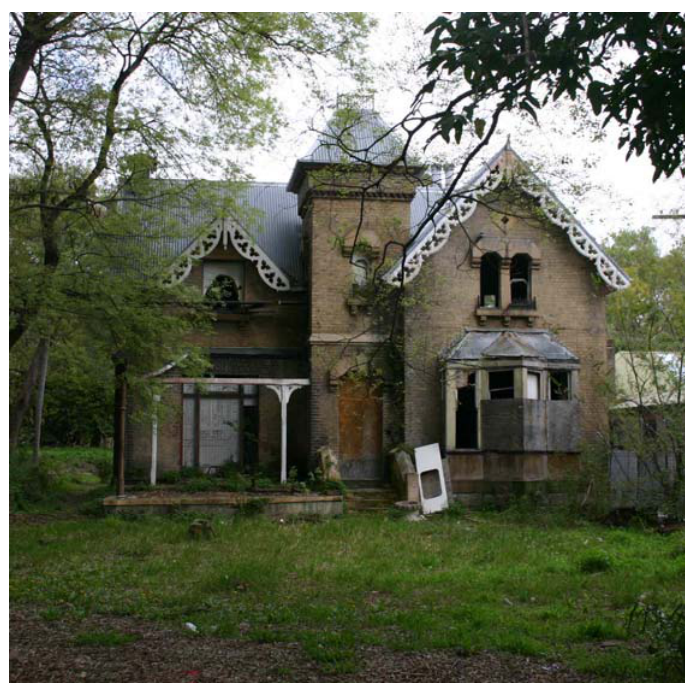
Figure 2. Reussdale (2007).